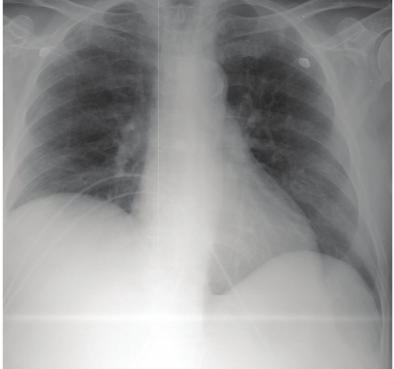
Figure 5: Portable chest X-ray. Showing elevation of right dome of the diaphragm. There is atherosclerotic calcification of aortic arch. The cardiac silhouette is within normal